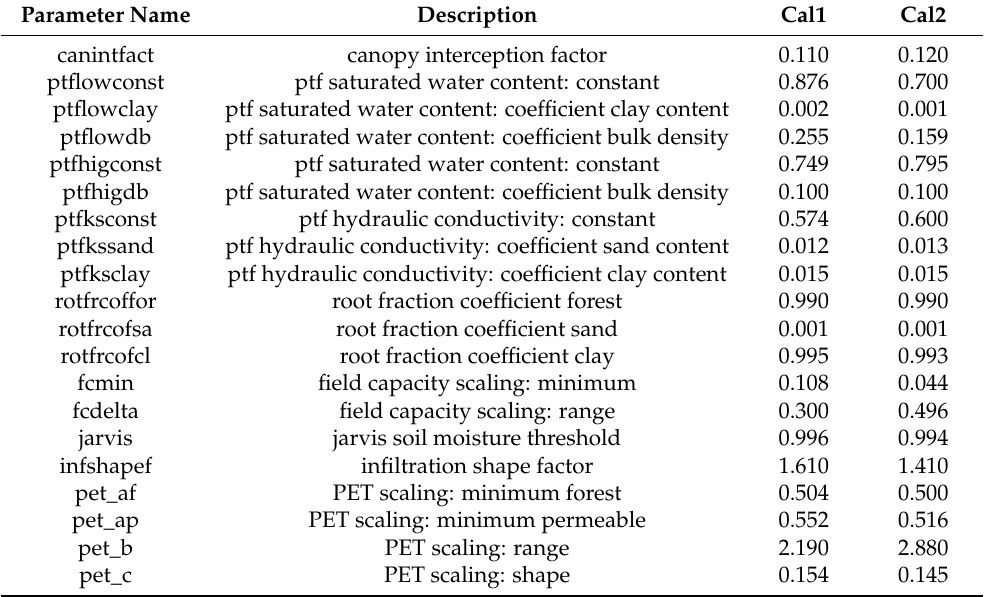
Figure 5. Results of the sensitivity analysis. The normalized sensitivity is given for the 21 parameters that were selected for subsequent model calibration. Sensitivity with respect to three objective functions is shown for the median of an ensemble of 8 different behavioral parameter sets. The whiskers represent the upper and lower limits of the inter-quantile range. Table 1. The 21 mHM parameters selected for calibration and their calibrated values for the featured runs of Cal1 and Cal2. Pedo transfer function is abbreviated with